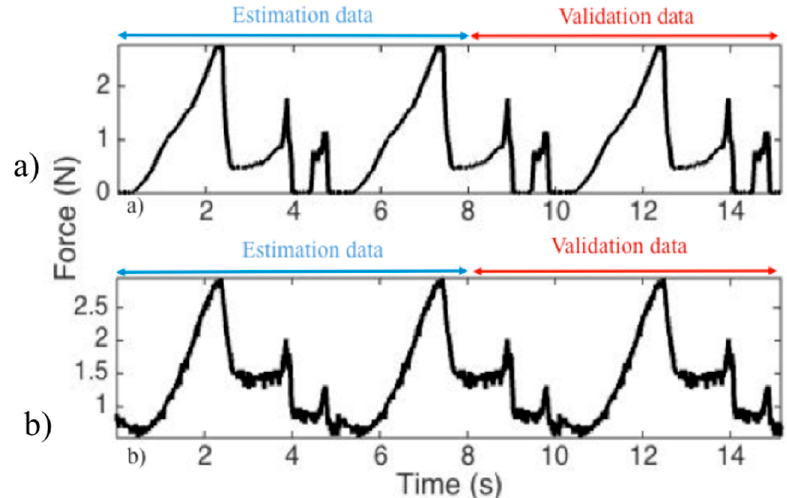
Figure 10. The dataset was divided into estimation (used for estimating the model) and validation (used for validating the results) data. ( a ) Input to the device based on the actual force measurements for a bovine heart tissue. ( b ) Output measured from the force sensor. The first 8 seconds of the input-output measurements was used estimation data. The next 8 seconds of data was used as validation data.